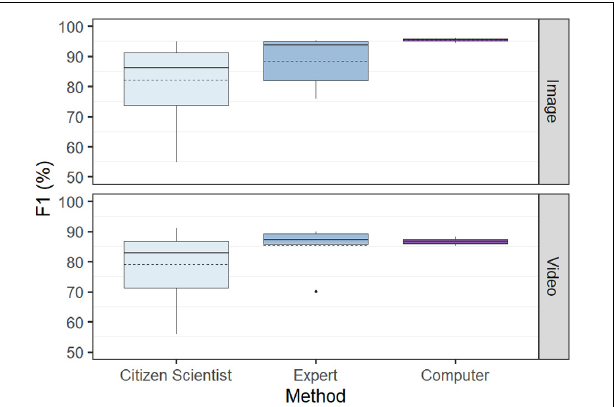
FIGURE 4 | Overall test performance in determining abundance (F1) by computer versus humans (citizen scientists and experts) based on identical tests using 50 images and 31 videos. The citizen scientist group had the highest variance and lowest performance, while the computer had the lowest variance and highest performance. Solid line denotes median, and dashed line denotes